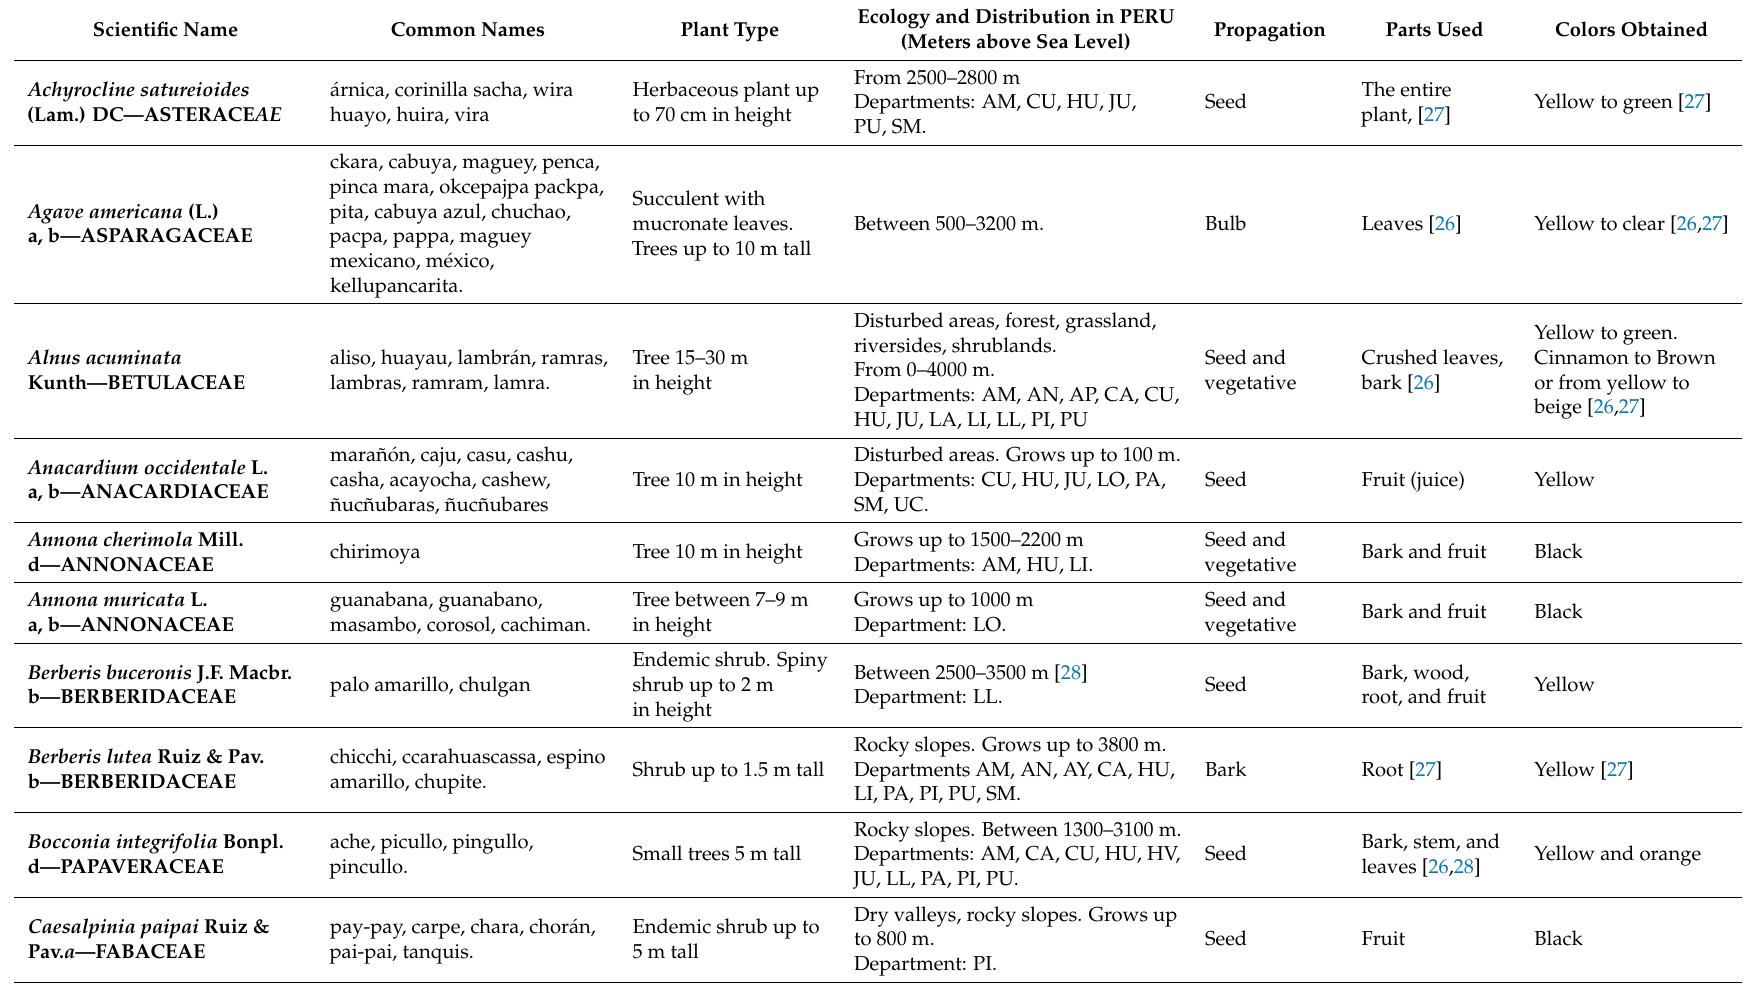
Table 2. Characteristics of dye plant species found in Northern